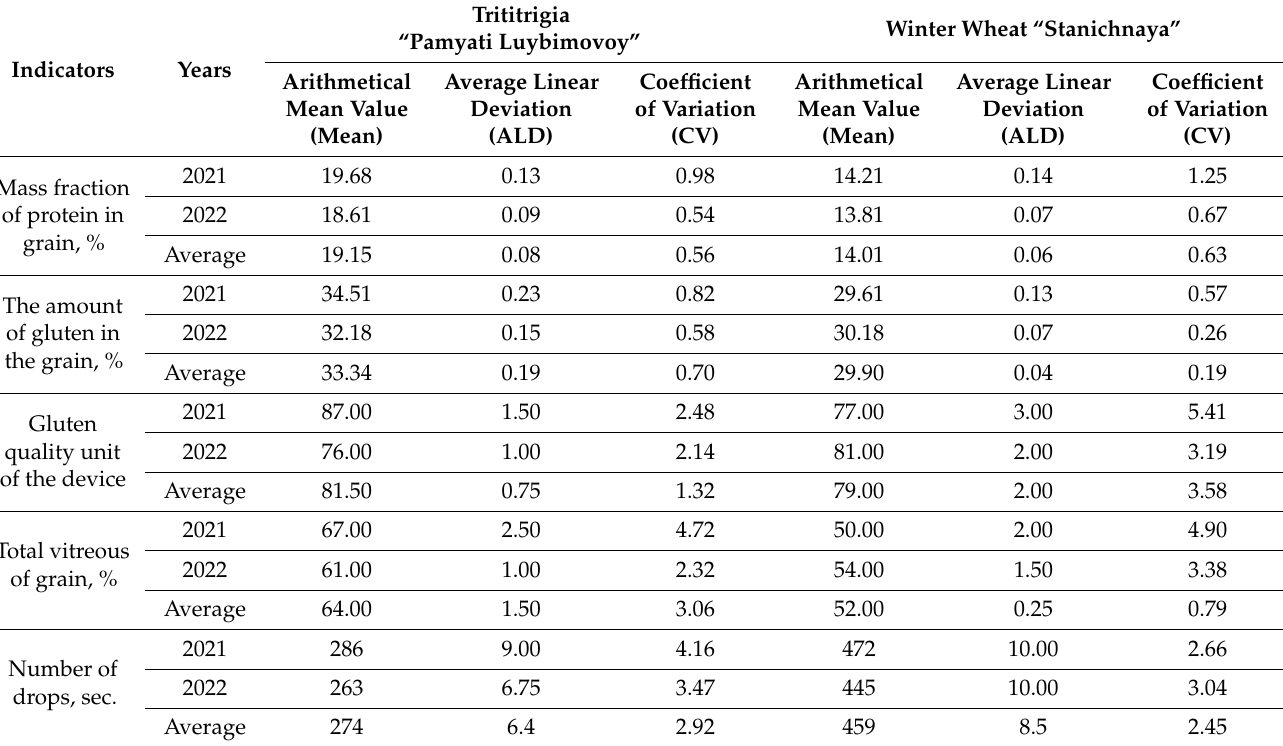
Table 3. Technological indicators of the